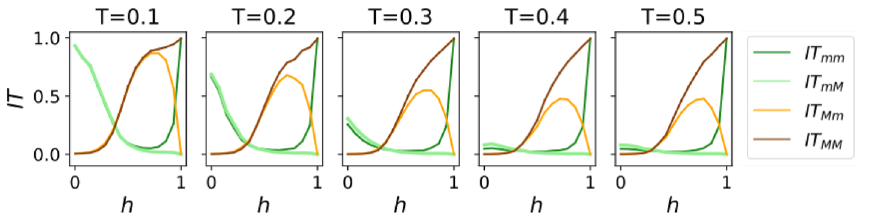
Figure 5. Information transmission observables as a function of the homophily parameter h , for Hybrid Contagion dynamics. Each column shows a different threshold T . The first subindex of each element of the legend indicates the source group, while the second subindex indicates the target group. Parameters used: N = 1000 nodes, m = 1 , minority fraction f a = 0.2 , M = 1000 realizations.